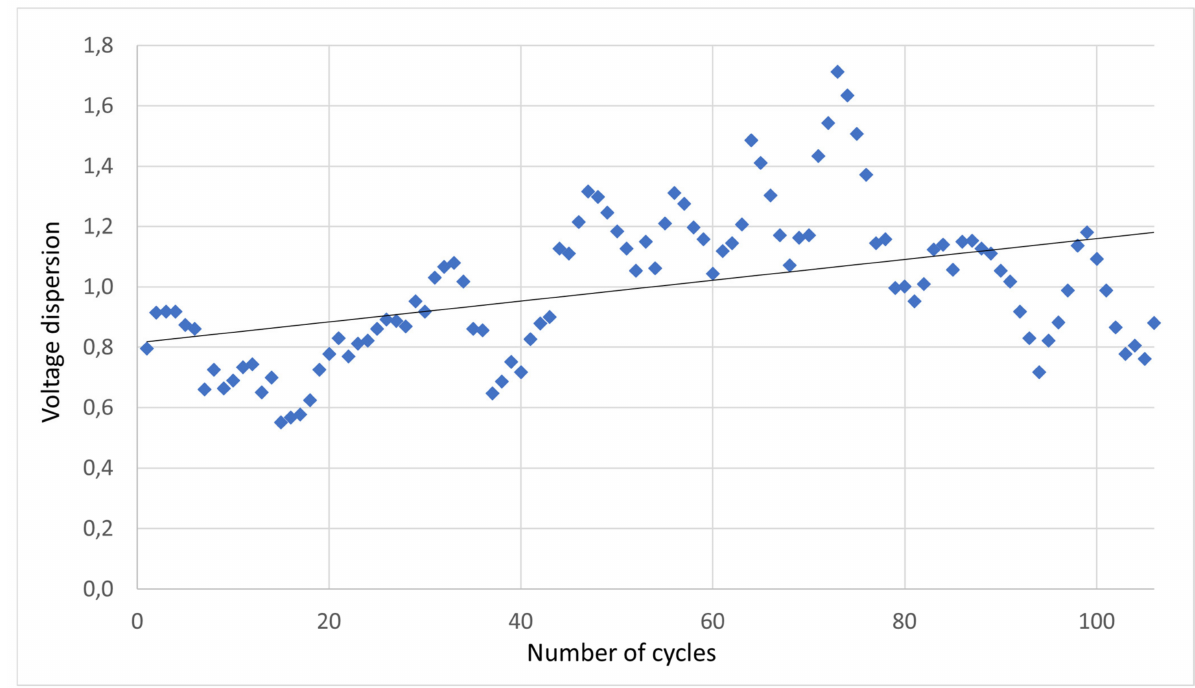
Figure 10. Weighted voltage dispersion of battery 5.